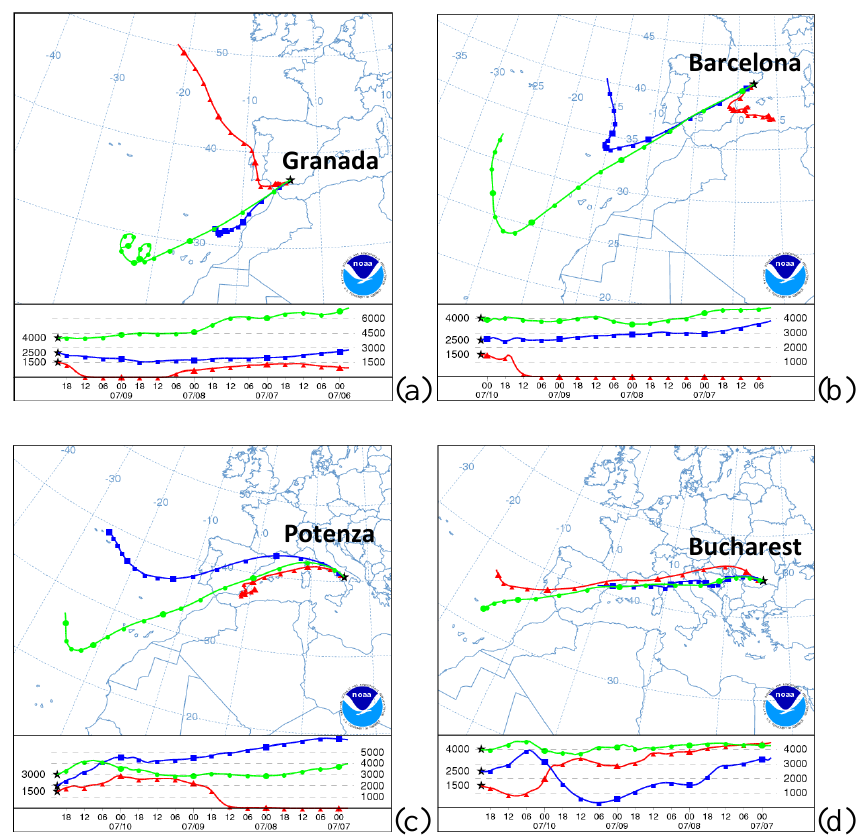
Figure 11. HYSPLIT 4-day back trajectories (a) in Granada on J09 at 21:00UT, (b) in Barcelona on J10 at 02:00UT, (c) in Potenza on J10 at 21:00UT and (d) in Bucharest on J10 at